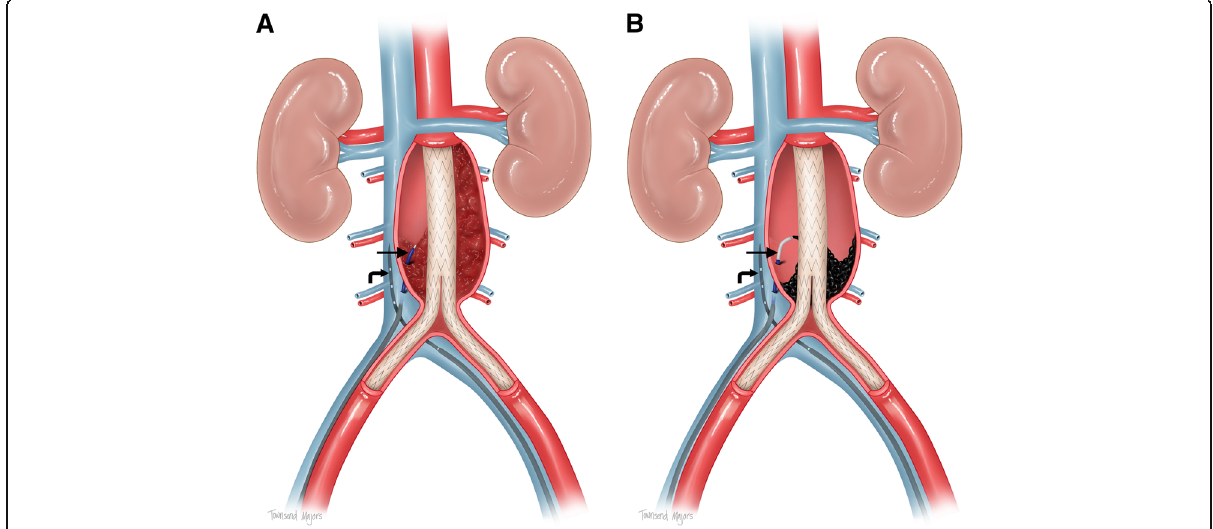
Fig. 2 a . Rosch-Uchida liver access set (straight arrow) is used to access the aortic aneurysm sac. The aneurysm sac is accessed, near the site of the type II endoleak, from the inferior vena cava (IVC) under sonographic guidance with an intravascular ultrasound (IVUS) probe (curved arrow). b . The Rosch-Uchida needle was exchanged for an angle-tipped catheter and microcatheter (straight arrow). Embolic material is administered via the microcatheter. IVUS probe (curved